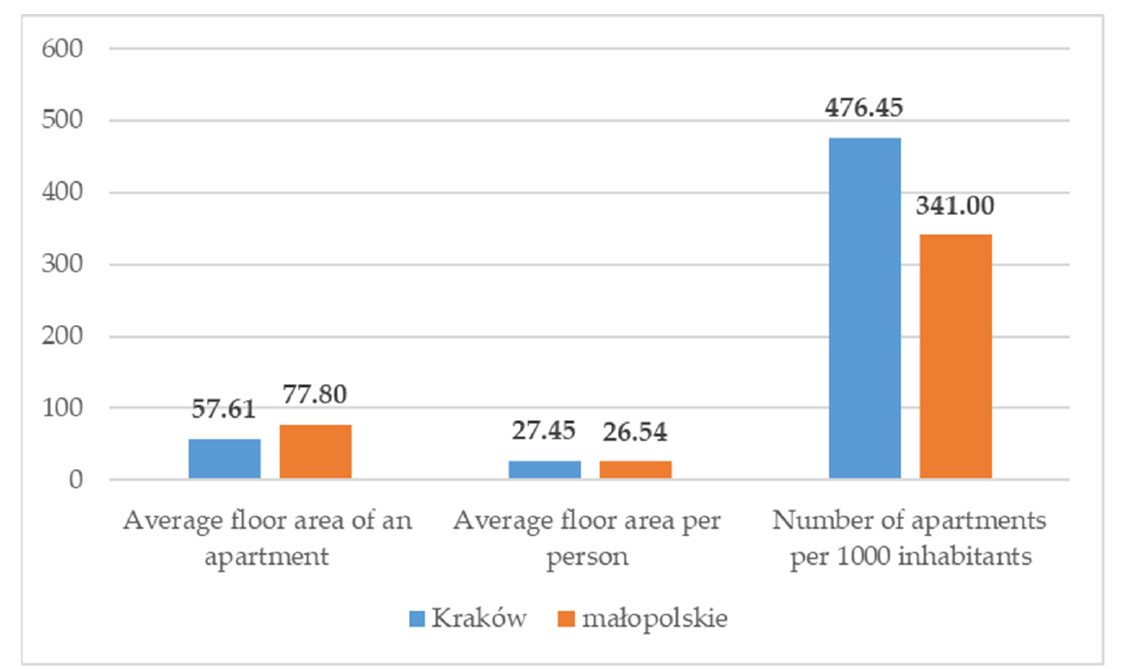
Figure 8. Indicators of housing infrastructure availability in Kraków and the Małopolska Province.